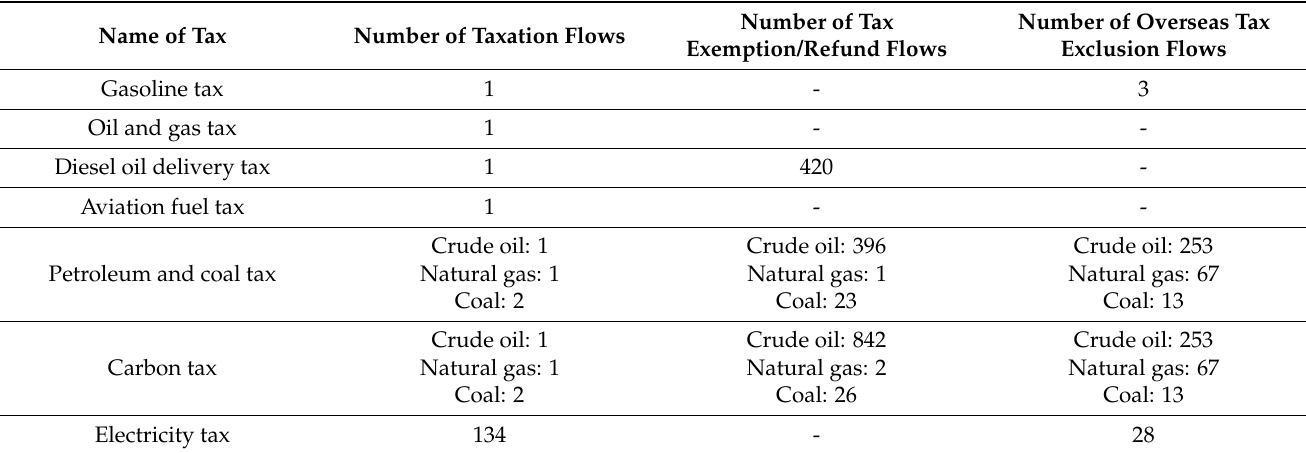
Table 3. Number of elementary flows on taxation, tax exemption/refund, and overseas tax exclusion input into inventory database for environmental analysis (IDEA)